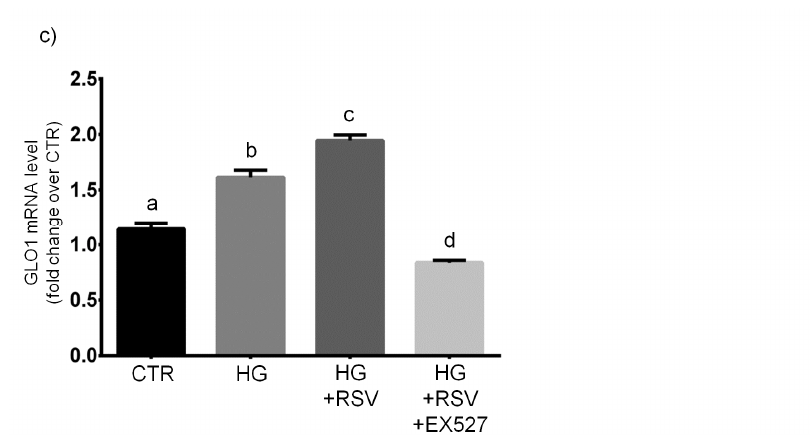
Figure 6. Effects of a 24-h treatment with either resveratrol alone (5 µM) or resveratrol+EX527 (5 µM and 13.4 µM, respectively) combination on the enzymatic activity ( a ), protein levels ( b ), as well as mRNA content ( c ) of GLO1 in high glucose-challenged HUVECs. Representative blots are also shown ( b ). Data are expressed as means and S.E.M. Abbreviations: CTR—vehicle; HG—high glucose; HG + RSV—high glucose + resveratrol; HG + RSV + EX527—high glucose + resveratrol + EX527; GLO1—glyoxalase 1. Means sharing the same letter are not significantly different from each other (one-way ANOVA and Tukey’s multiple comparisons test): Panel a: a vs. b, p < 0.01; b vs. c, p < 0.001; a vs. c, p < 0.05; b vs. d, p < 0.05; a vs. d, p < 0.001; c vs. d, p < 0.001 ( N = 4). Panel b: ( N = 4). Panel c: a vs. b, p < 0.001; b vs. c, p < 0.01; a vs. c, p < 0.001; a vs. d, p < 0.01; b vs. d, p < 0.001; c vs. d, p < 0.001( N = 5).